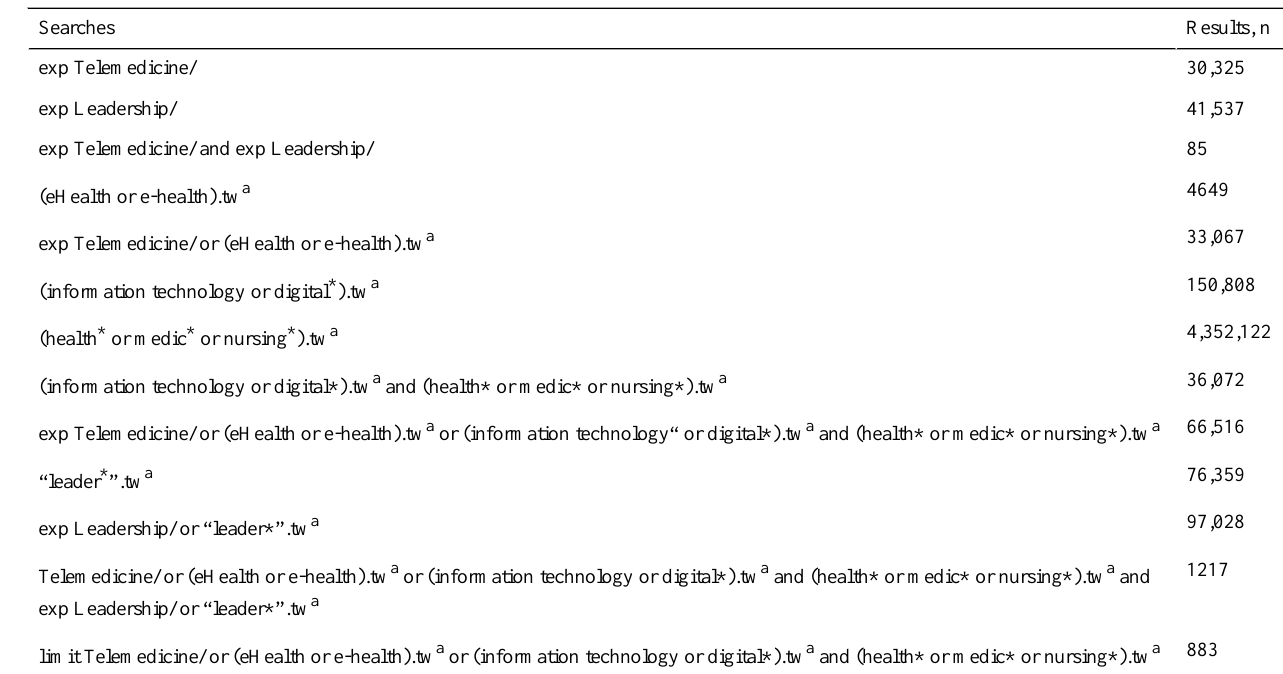
Table 1. Search strategy applied in MEDLINE using Medical Subject Headings terms and search terms with abstract, title, and keyword limitations. The search was undertaken on October 19, 2020.